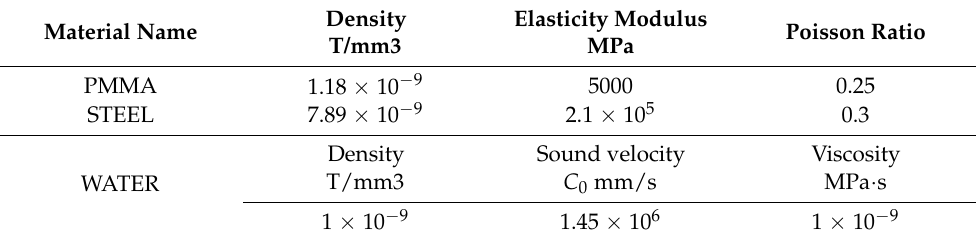
Table 3. The properties of material PMMA, STEEL and WATER.